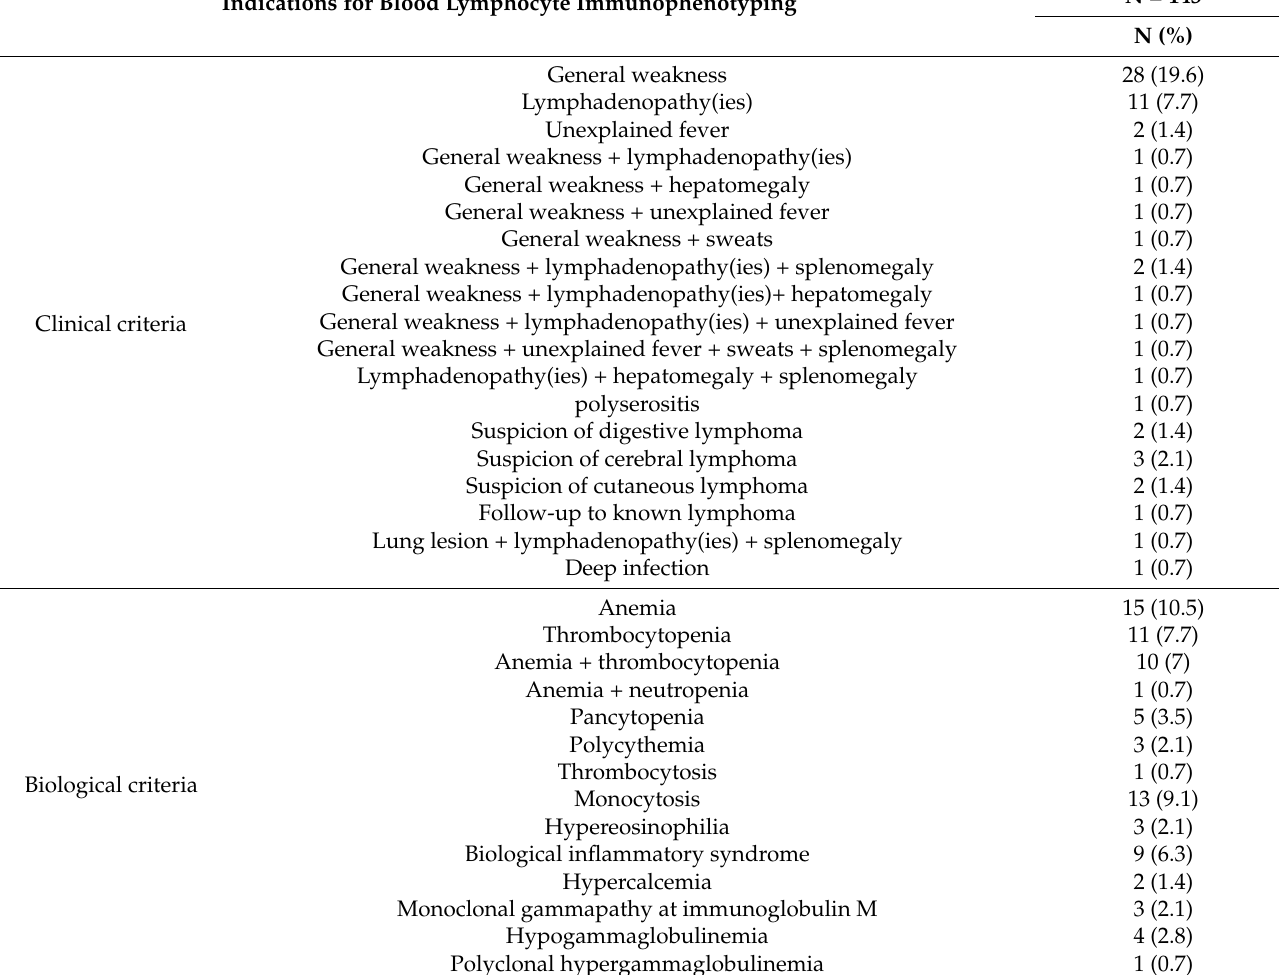
Table 2. Indications for blood lymphocyte immunophenotyping prescription in the absence of lymphocytosis (LG −